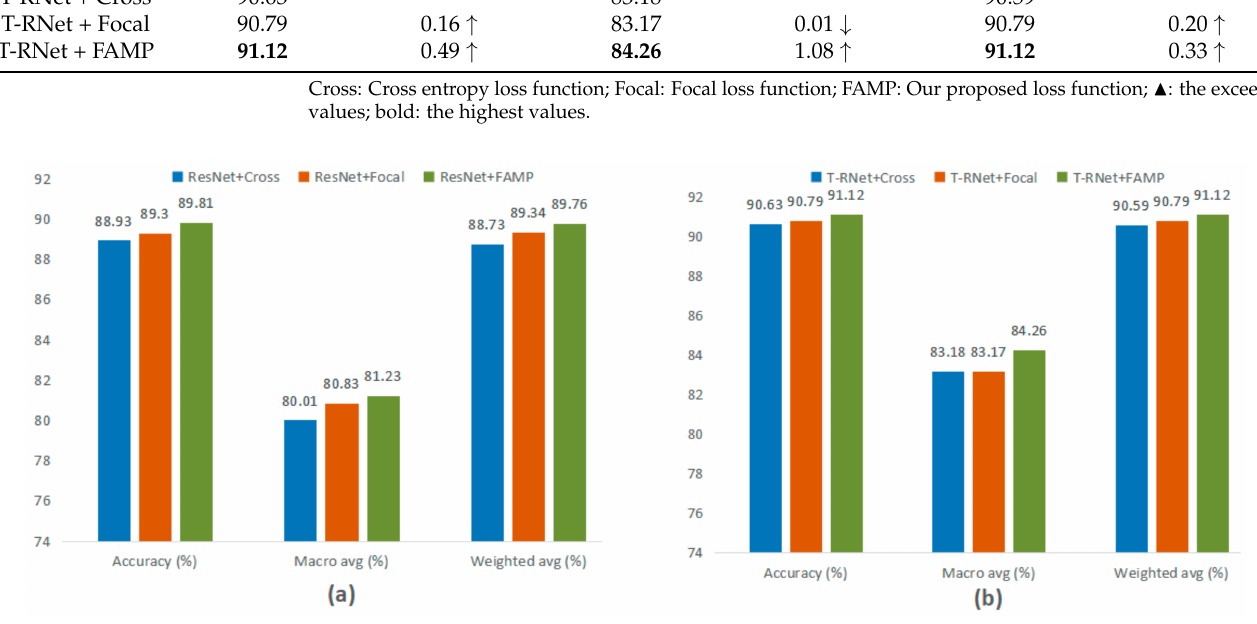
Figure 8. ( a ) Performances of different loss functions on ResNet. ( b ) Performances of different loss functions on